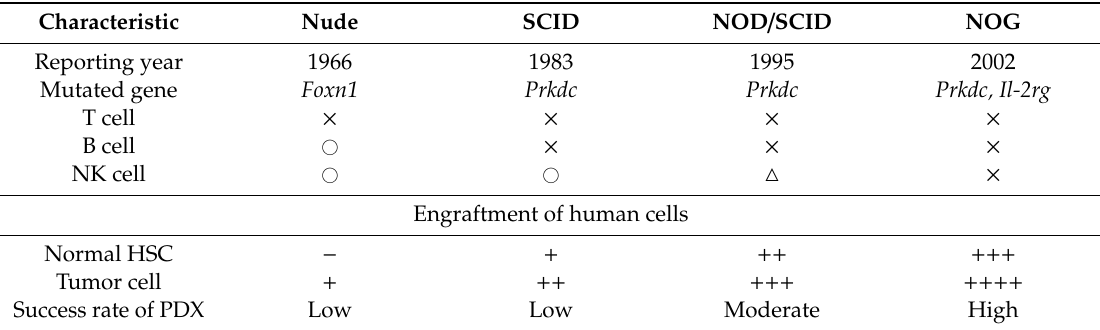
Table 1. Development and characteristics of immunodeficient mice used in animal models. Characteristic Nude SCID NOD / SCID NOG Reporting